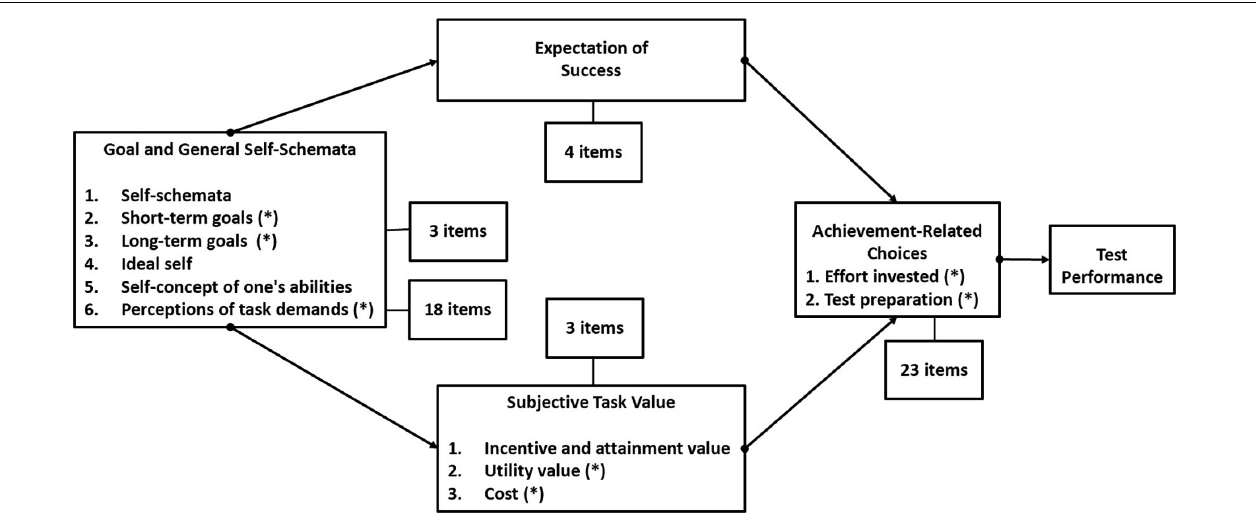
FIGURE 1 | Schematic picture of expectancy-value theory applied to a test preparation context and distribution of questionnaire